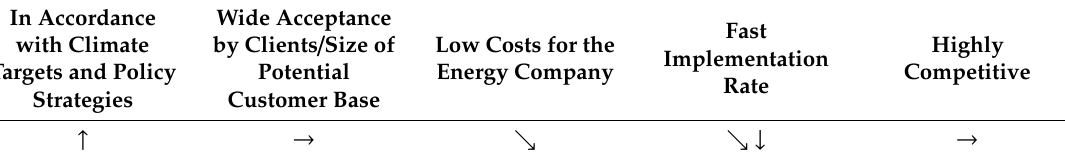
Table 5. Assessment of supplying system solutions as a business model for energy